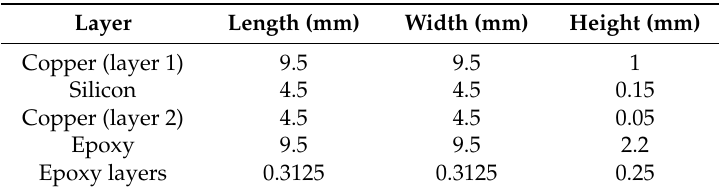
Table 2. Material parameters according to literature data.